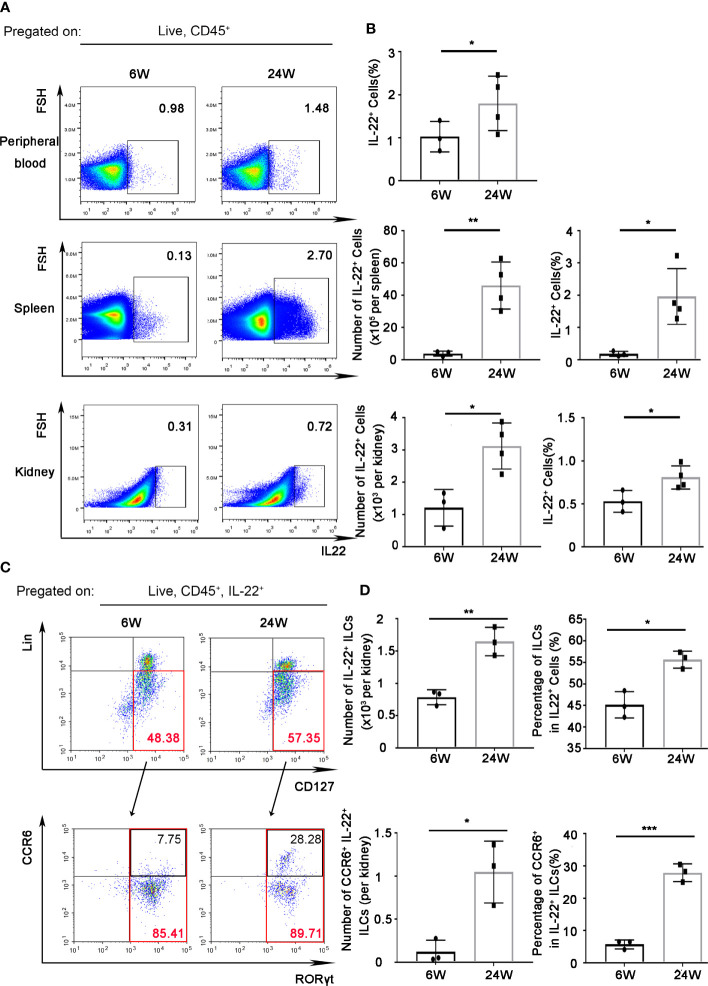
IL-22 was mainly expressed by ILC3s in kidney of lupus-prone mice. IL-22+ cells in peripheral blood, spleen, kidney from 6-weeks or 24-weeks-old MRL/Fas Mice were analyzed by flow cytometry. (A) The gating strategy for detecting IL-22+ cells in peripheral blood, spleen, and kidney. (B) The quantitative analysis of the percentage and amount of IL-22+ cells in peripheral blood, spleen, and kidney. (C, D) The gating strategy for detecting IL-22+ cell subsets and analysis of IL-22+ ILCs (Lin-CD127+), IL-22+ILC3s (Lin-CD127+RORγt+), and CCR6+ IL-22+ ILC3s in kidney. Data were expressed as mean ± SD, and are representative of three independent experiments. T-test was used for comparison between groups (*P < 0.05, **P < 0.01, ***P < 0.001). ILCs, innate lymphoid cells.